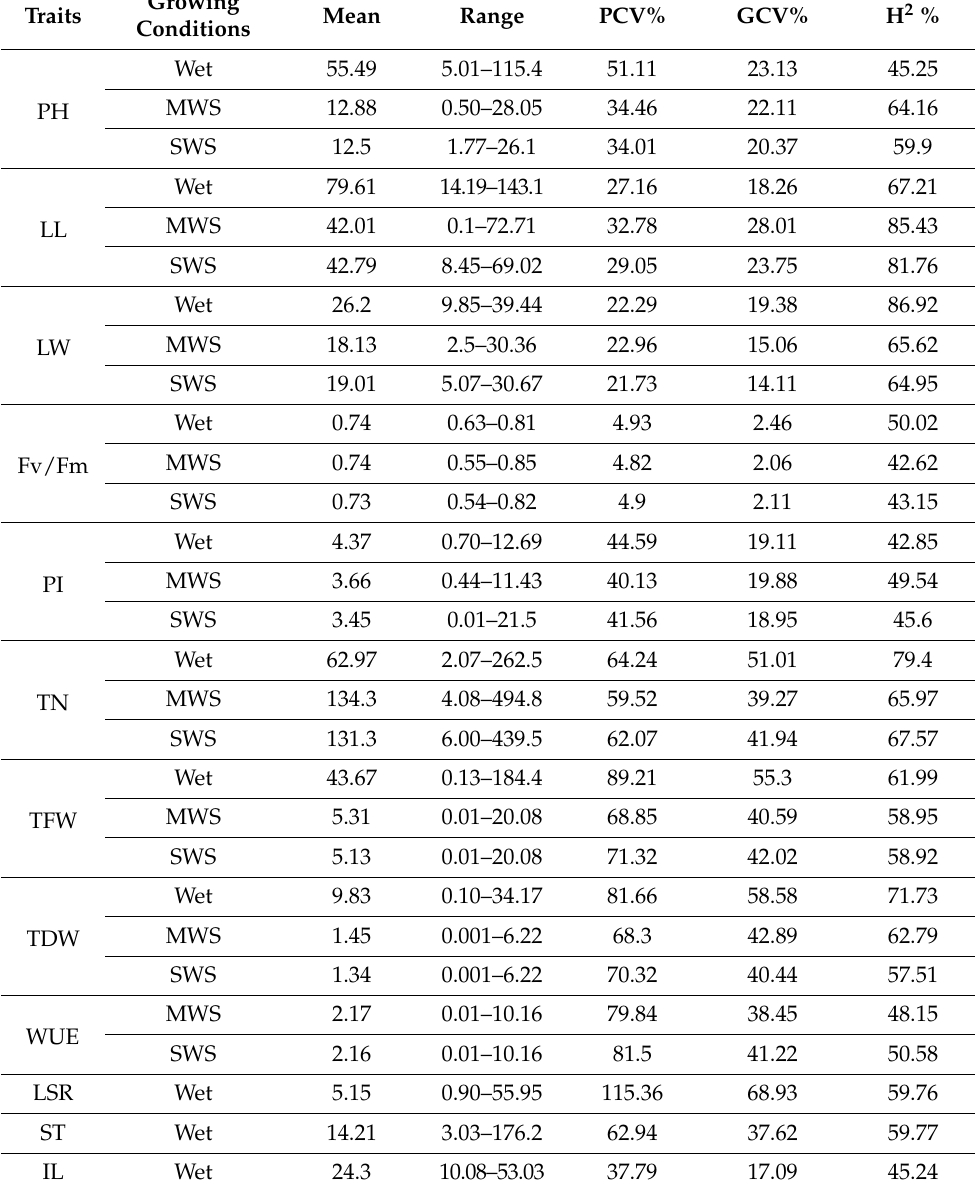
Table 2. Variations and heritability in agro-morphological traits of Napier grass genotypes grown under wet and dry season conditions—either exposed to moderate water stress (MWS) or severe water stress (SWS)—for two